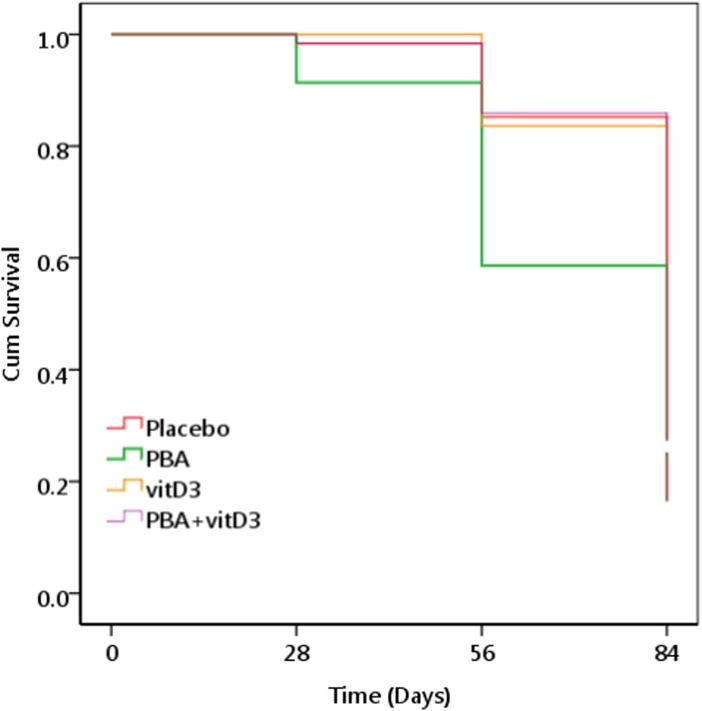
Kaplan Meier survival graph for monocyte-derived-macrophage (MDM)-mediated killing of Mycobacterium tuberculosis (Mtb).Data are expressed as viability of Mtb in ‘relative CFU (colony forming unit) counts’. A ‘relative CFU count’ was calculated by normalizing the data in each time point with the inoculated Mtb CFU. A cut-off of 0.1 was considered as zero. PBA-group exhibited significantly earlier decline in intracellular Mtb CFU counts after MDM-mediated killing compared to the placebo-group.